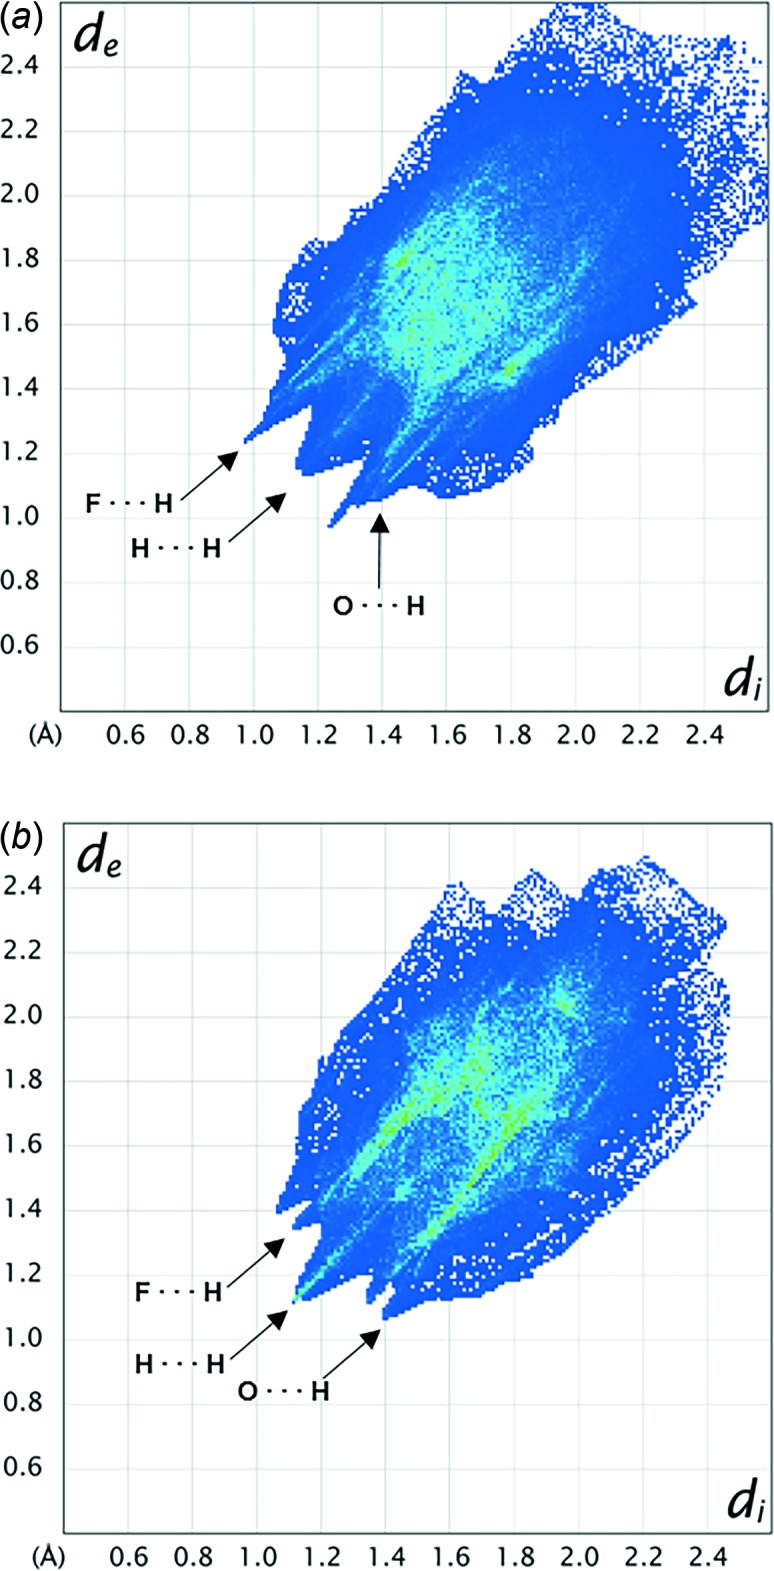
The overall two-dimensional fingerprint plots for (a) I and (b) II.